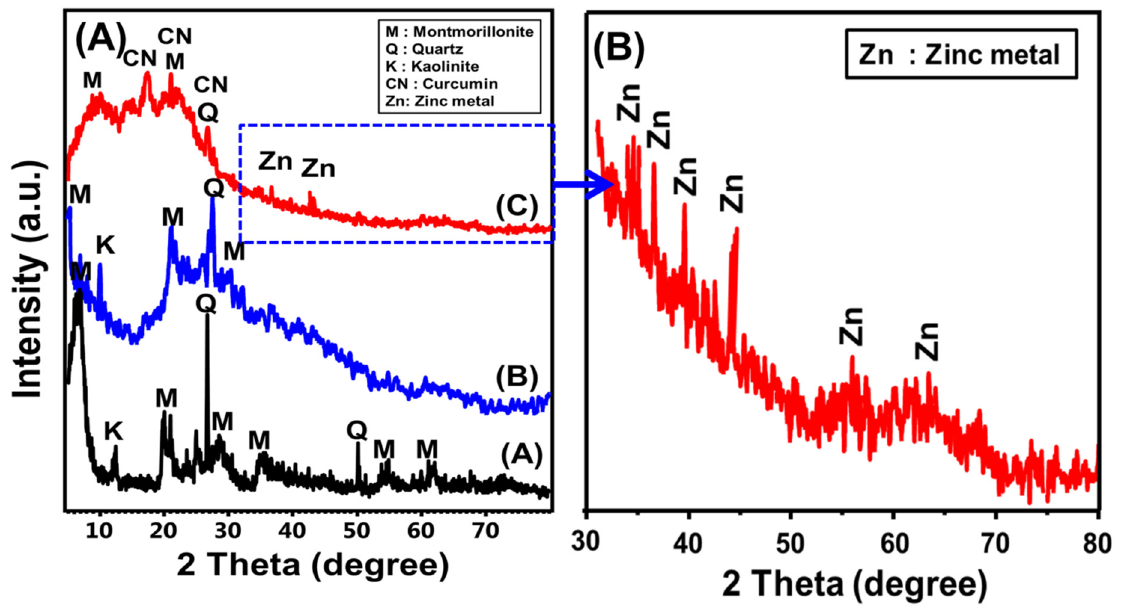
Figure 1. Shows ( A ) XRD patterns of the studied materials (bentonite ( A (A)), acid-activated bentonite ( A (B)), and synthetic Zn@CN/BE structure ( A (C))) and ( B ) focus image on the diffraction patterns of the pillared zinc